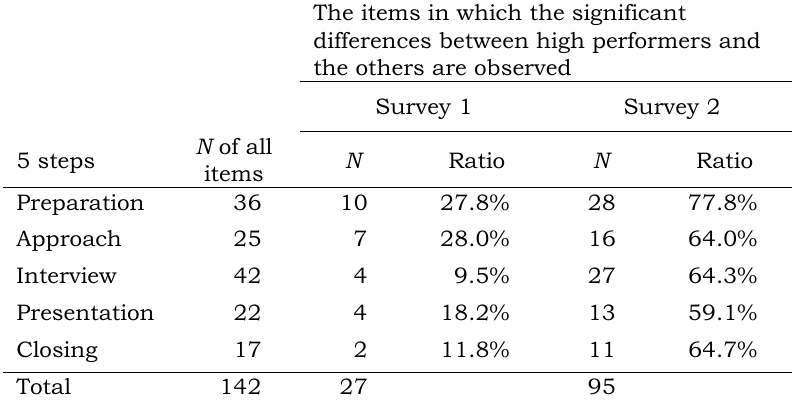
Table 1. Differences of the sales skills between high performers and the others The items in which the